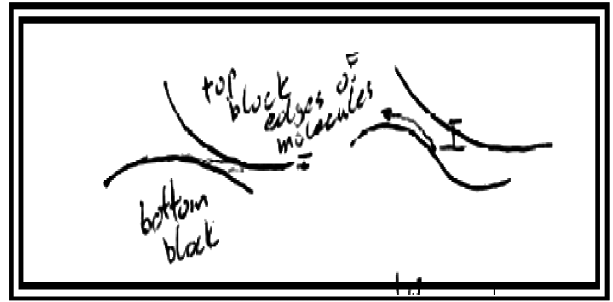
FIG. 6. The atoms of the wooden block rub against the atoms of the tabletop.